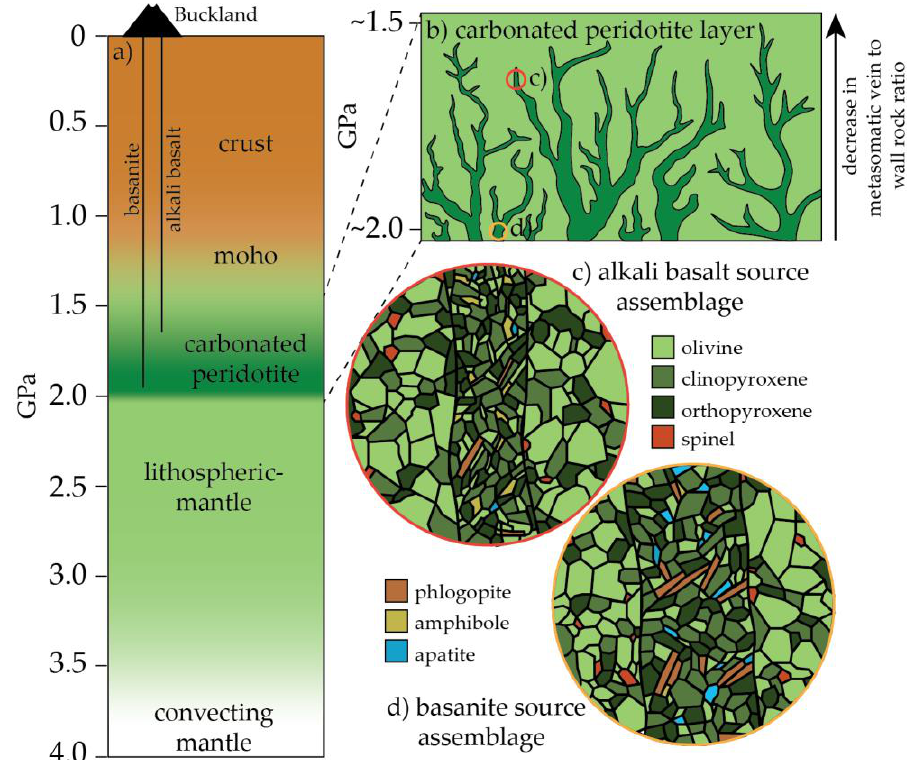
Figure 10. Schematic representation of the source region of the Buckland volcanic province prior to the generation of the alkali basalt and basanite melts, but after the hydrous-alkali-carbonatite metasomatic event. ( a ) A cross-section of the lithosphere underneath Buckland; LAB depth from [38], and MOHO depth from [44]. ( b ) Decrease in the degree of metasomatism at shallower depths with source regions circled for alkali basalt (red) and basanites (orange). ( c , d ) Mineralogy of the peridotite and olivine-websterite domains that contributed to the alkali basalt (c) and the basanite (d)